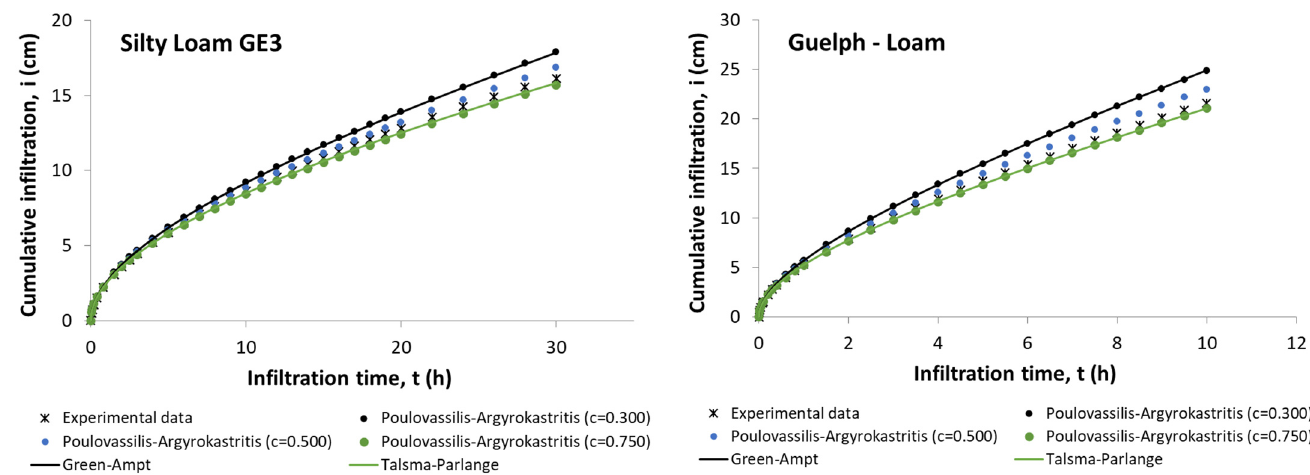
Figure 1. Comparative presentation of the experimental relationship i(t) and the predicted ones according to equations of Talsma–Parlange, Green–Ampt, and Poulovassilis–Argyrokastritis (Equa- tion (1) for c = 0.300, 0.500, and 0.750).